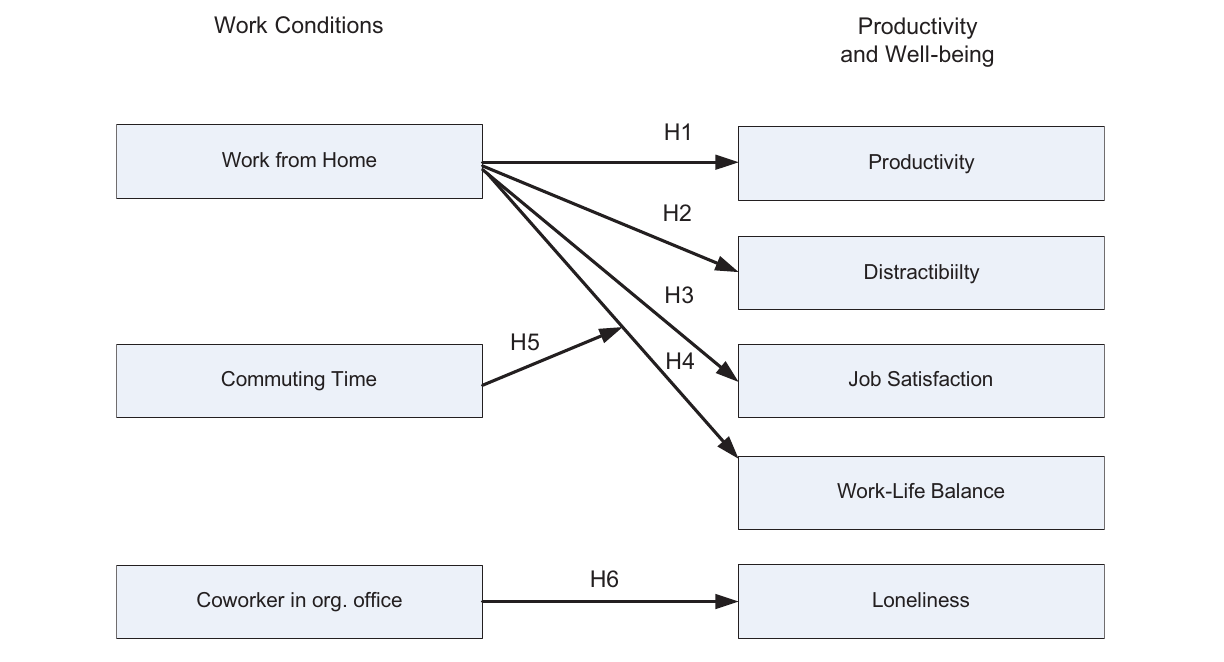
Frontiers in Psychology |